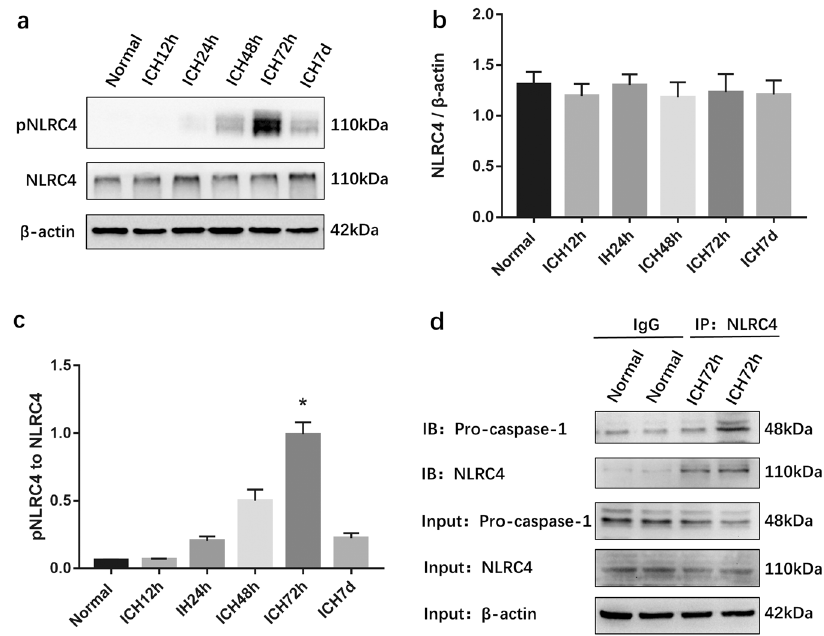
Fig. 2 Expressions of NLRC4 and pNLRC4 after intracerebral hemorrhage, and the activation of the NLRC4 in fl ammasome. a – c NLRC4 and pNLRC4 expressions in the peri-hematoma area of sham and ICH rats were detected by Western blot at 12, 24, 48, 72 h, and 7 days after surgery, respectively (six rats for each group after ICH). * P < 0.05, compared with Sham group. d The results of Co-Immunoprecipitation showed the interaction of NLRC4 and pro-caspase-1 after